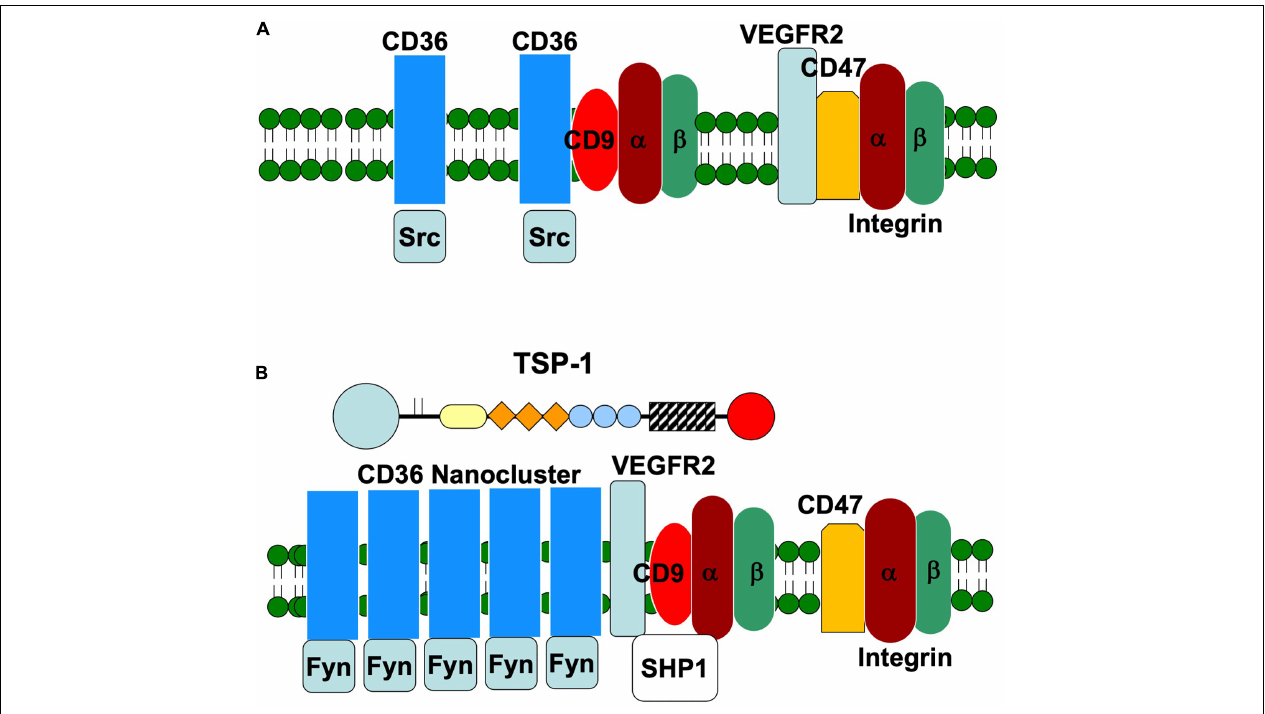
FIGURE 2 | Schematic representation of the organization of endothelial membrane proteins in the absence (A) and presence (B) of TSP-1. In the absence of TSP-1, Src co-immunoprecipitates with CD36. Fyn is preferentially associated with CD36 in the presence of TSP-1 and the formation of CD36 nanoclusters amplifies Fyn-mediated signal transduction. The presence of TSP-1 also promotes the dissociation of VEGFR2 from CD47 and the association of VEGFR2 with CD36. Integrins and SHP1 also complex with